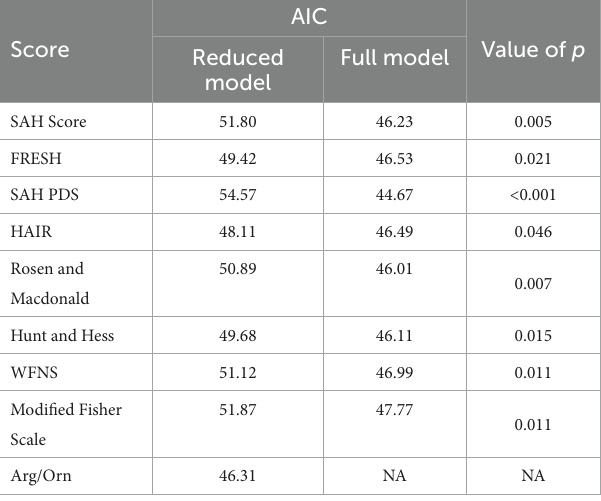
TABLE 3 Comparison of full versus reduced regression models.